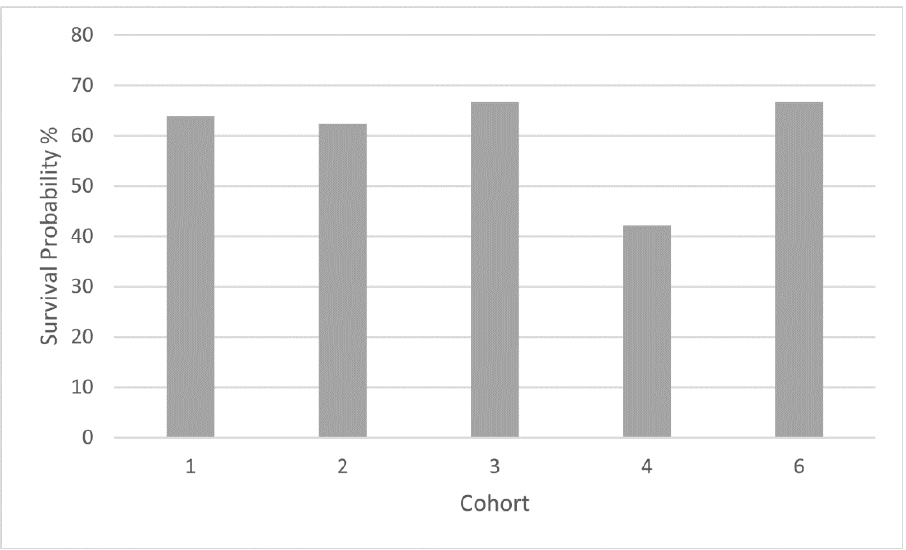
Figure 4. Five-year overall survival probability, groups 1–4 and 6 (metastasized patients) as percentages.